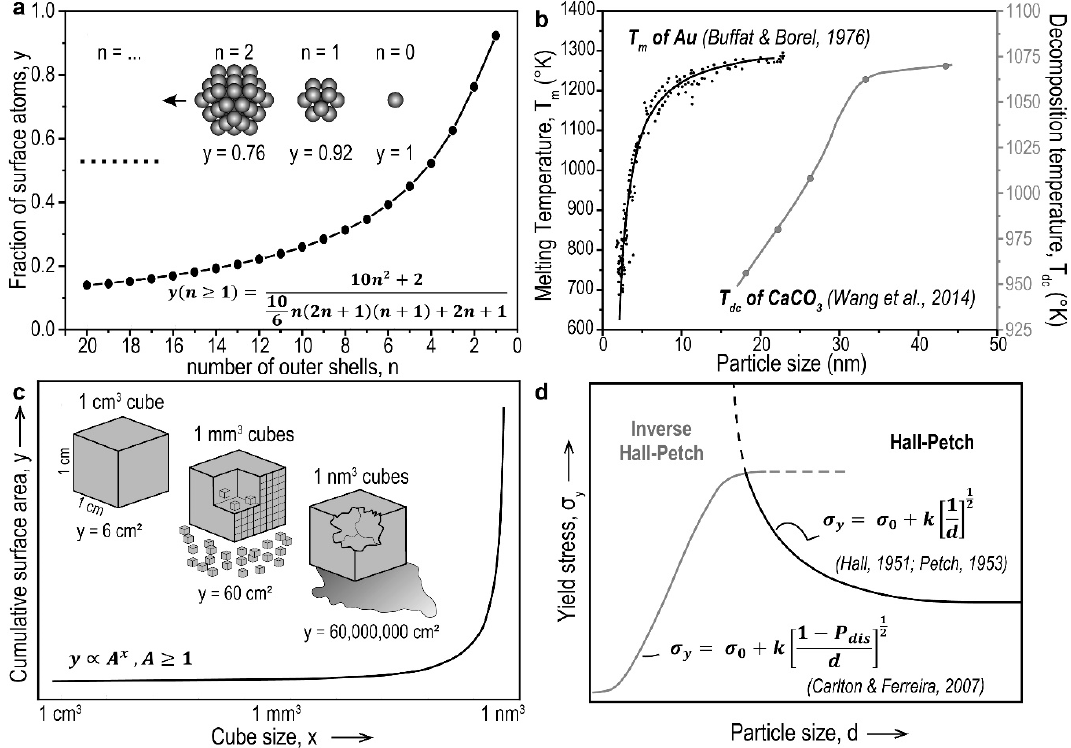
Figure 2. Key characteristics of nanoparticles and nanostructured materials. ( a ) A simple model of hexagonal close-packed balls illustrating the effect of particle miniaturization. The fraction of surface particles increases near-exponentially with decreasing number of outer shells, or particle size (after [11,13]). ( b ) The melting temperature of Au [67] and the decomposition temperature of CaCO 3 [68] particles decrease sharply as particle size decreases within the nm-realm. ( c ) The cumulative surface area of polycrystals increases exponentially as the grain size continues to decrease. ( d ) The empirical relation between yield strength σ y and grain size d , known as the Hall-Petch (HP) effect [76,77], reverses for very small d (after [78,79]). The expression for σ y in the inverse-HP regime is the model by Carlton & Ferreira (2007) [79], where k is a constant and P dis is the probability of a dislocation being absorbed by a grain boundary.